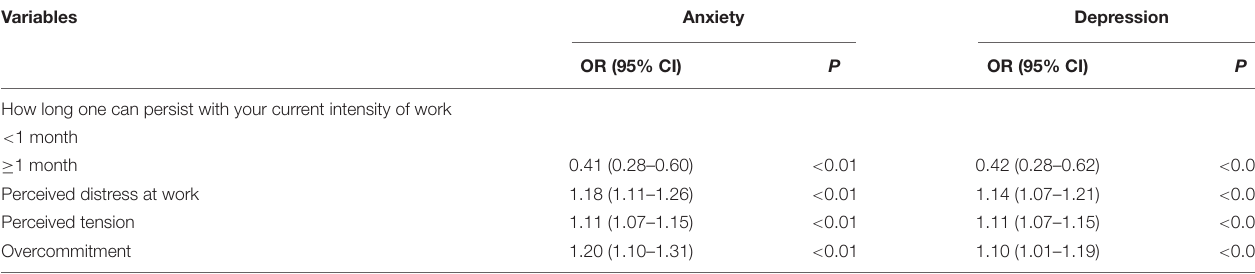
TABLE 5 | Associations between mental health status and background variables (multivariate stepwise logistic regression) a .